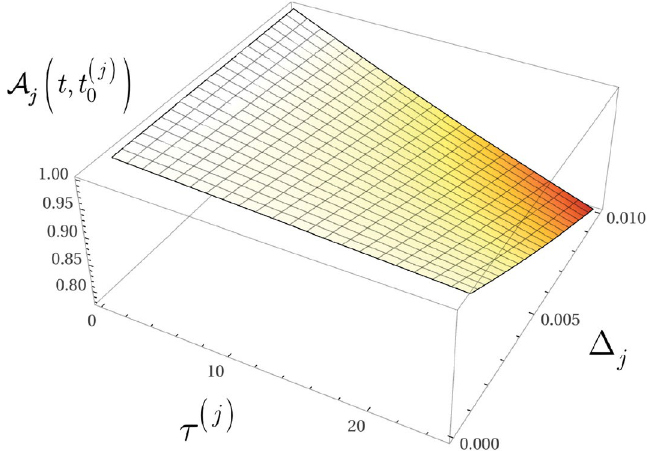
( t ) target function intensity, (cid:31) j i